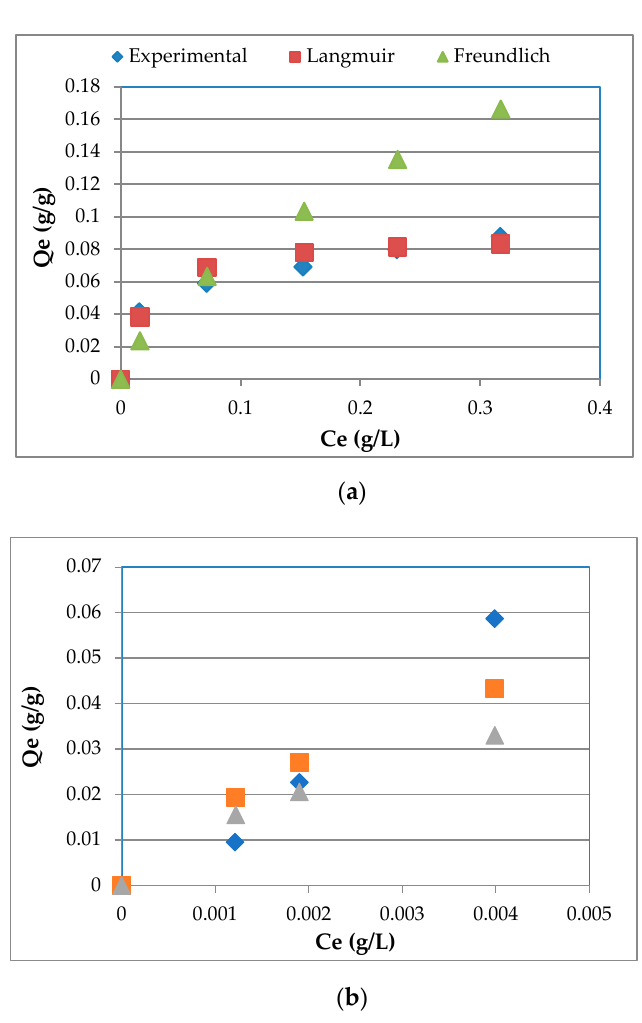
Figure 11. Equilibrium curves for sorption of Congo red onto ( a ) S20_70 / 30 and ( b ) ERH. Table 5. Equilibrium constants for sorption of Congo red onto S20_70 / 30 and cotton yarn (ERH).